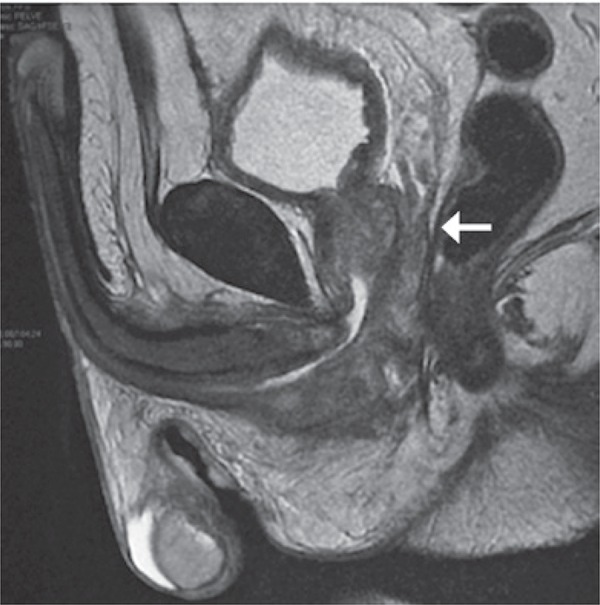
Ressonância nuclear magnética de pelve demonstrando tumor acometendo uretra (seta)